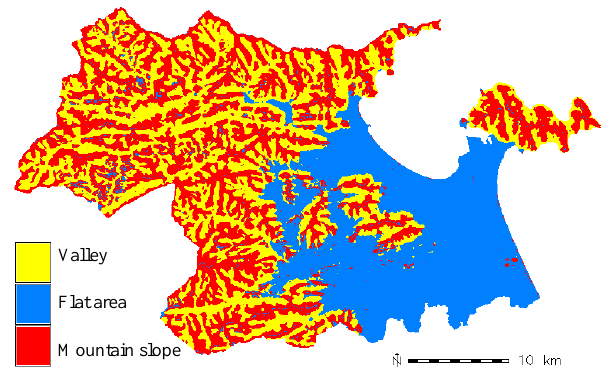
Figure 10. Landform classification map from SRTM. Table 5. Mean of absolute error (MAE) from slope error maps of GDEM and SRTM on each landform unit.